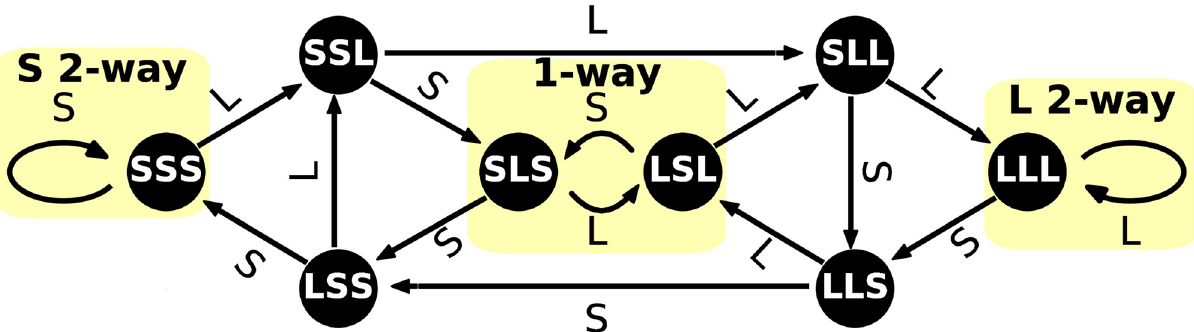
Fig 1. Network representation of a CODYM. Network depiction of a 3 rd -order CODYM, where turn lengths are binarized as short ( S ) or long ( L ). Nodes (black circles) represent states that are defined by the lengths of the 3 previous turns, respectively; edges (arrows) represent transitions between states and are labeled with the length of the turn on that transition. The areas highlighted in yellow represent important sub-networks we refer to as short two-way information exchanges (labeled “ S 2-way”), one-way information exchanges (labeled “1-way”), and long two-way information exchanges (labeled “ L